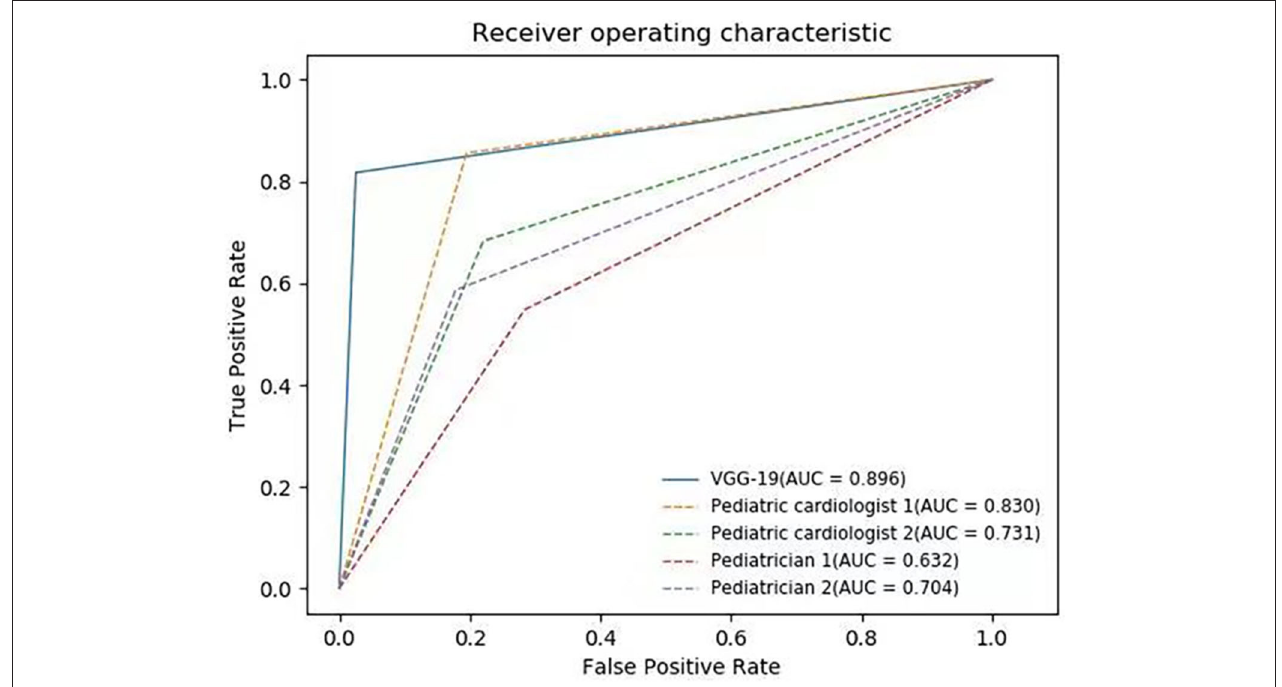
FIGURE 2 | ROC curves of VGG-19 and four human experts. The average AUC of VGG-19 is